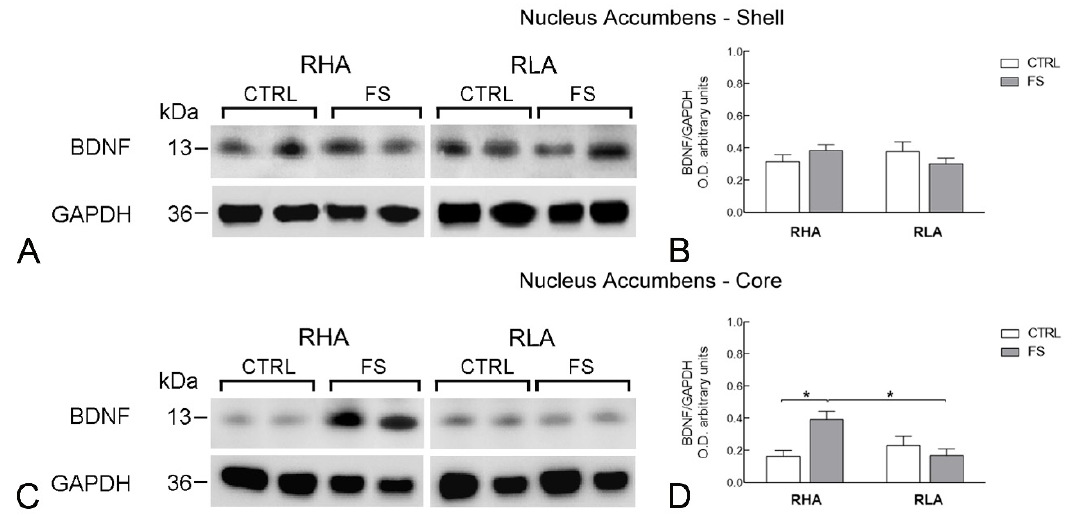
Figure 2. Western blot analysis of brain-derived neurotrophic factor (BDNF) protein levels in the nucleus accumbens shell ( A , B ) and core subregions ( C , D ) of RHA and RLA rats under baseline conditions (CTRL) and after a 15 min session of forced swimming (FS). ( A , C ) shown are representative samples from two rats; and ( B , D ) densitometric analysis of the BDNF/GAPDH band gray optical density (O.D.) ratios. Columns and bars denote the mean ± S.E.M. of eight rats in each experimental group. *: p < 0.05 (Tukey’s post hoc test or Sidak’s correction for multiple comparisons).